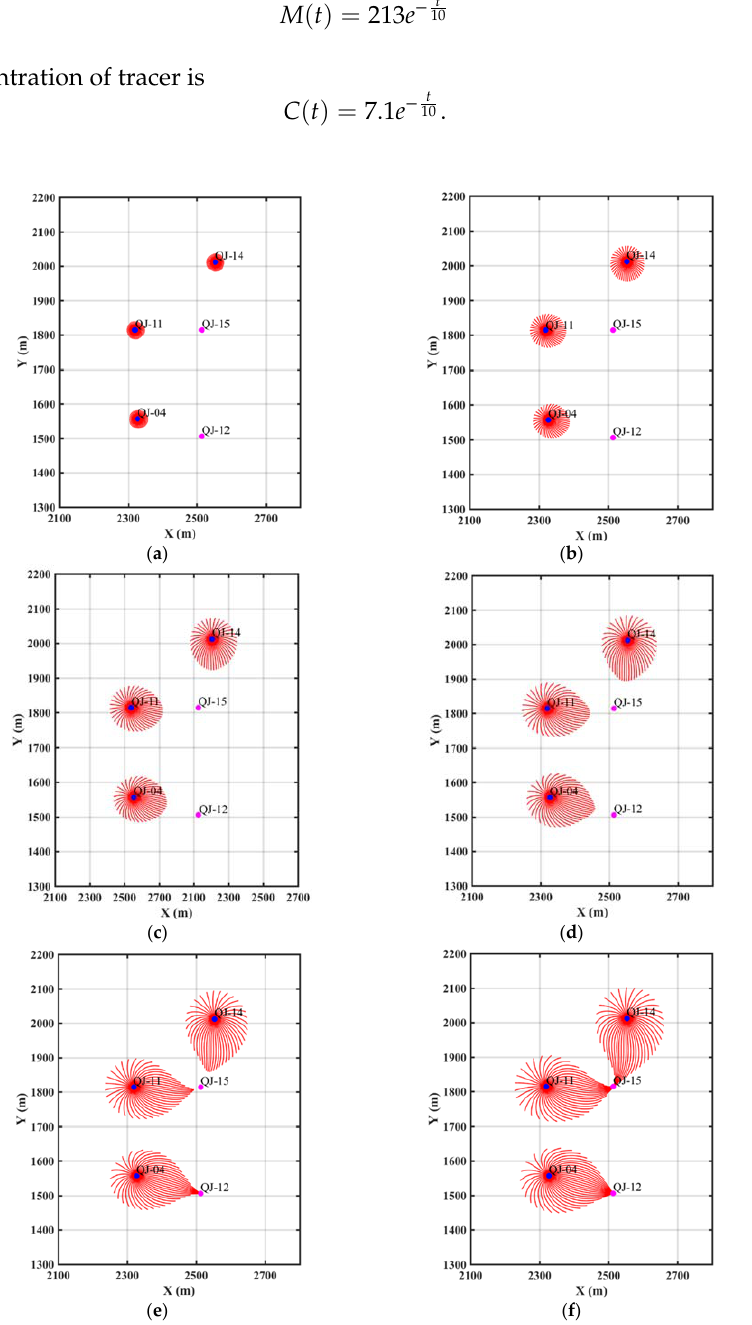
Figure 5. Streamline simulation results for porosity φ = 0.05. ( a ) t = 0.1 day; ( b ) t = 0.4 day; ( c ) t = 0.8 day; ( d ) t = 1.2 day; ( e ) t = 1.6 day; ( f ) t = 2 day; the red lines are water flow trajectories.